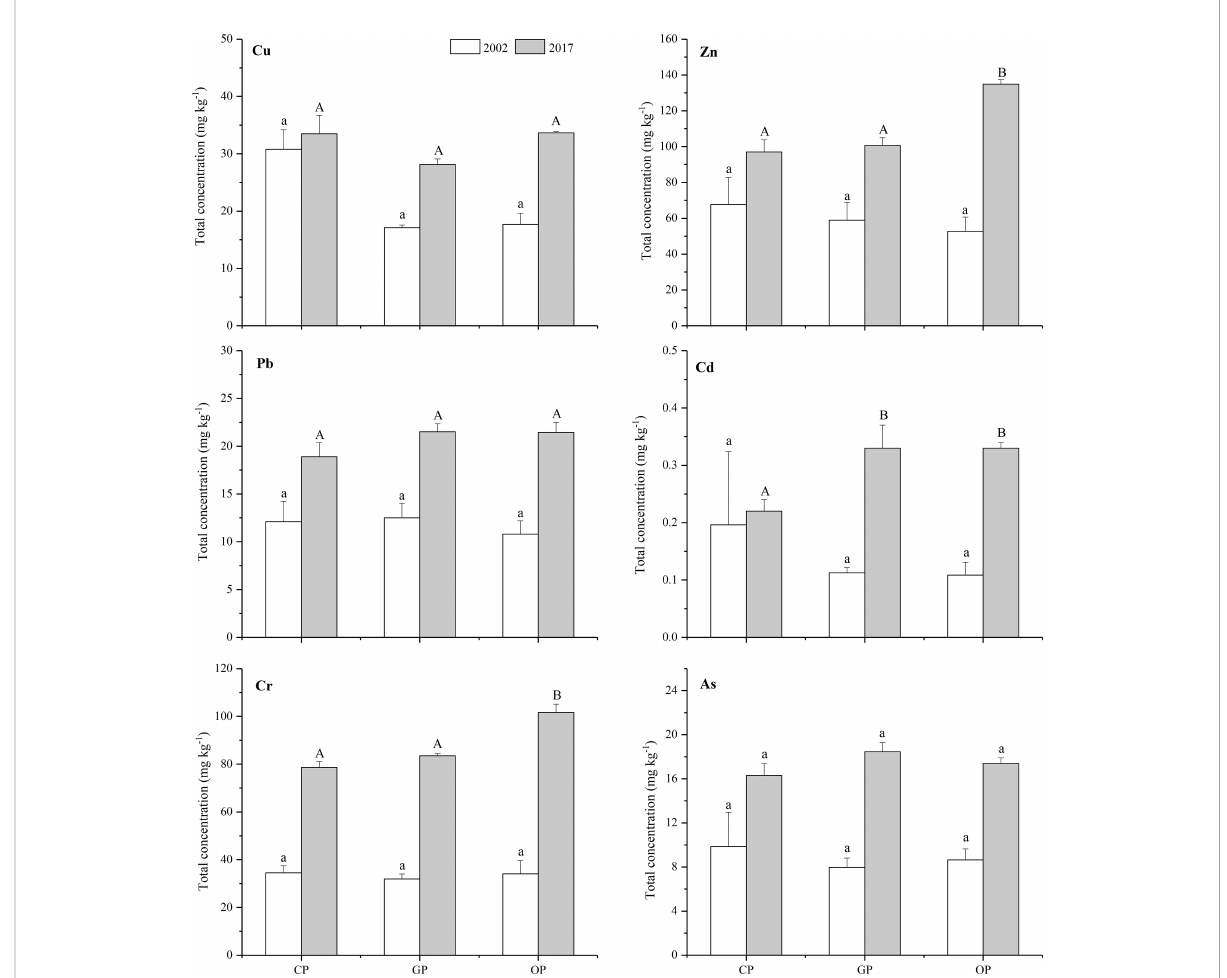
0.1< RQ <1 was medium risk, and RQ ≥ 1 was high risk (22). with RQ in the three treatments. Both OTC and DC in the soil reached high risk in OC and CC treatments, while TC and CTC